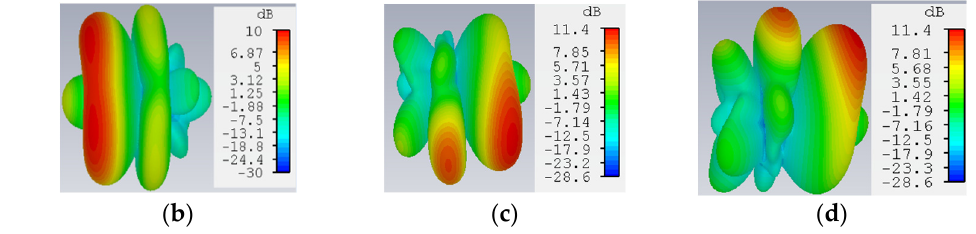
( d ) Figure 8. 3D radiation patterns of the antenna at: ( a ) 45 (cid:2868) ; ( b ) 90 (cid:2868) ; ( c ) 225 (cid:2868) ; ( d ) 315 (cid:2868) .